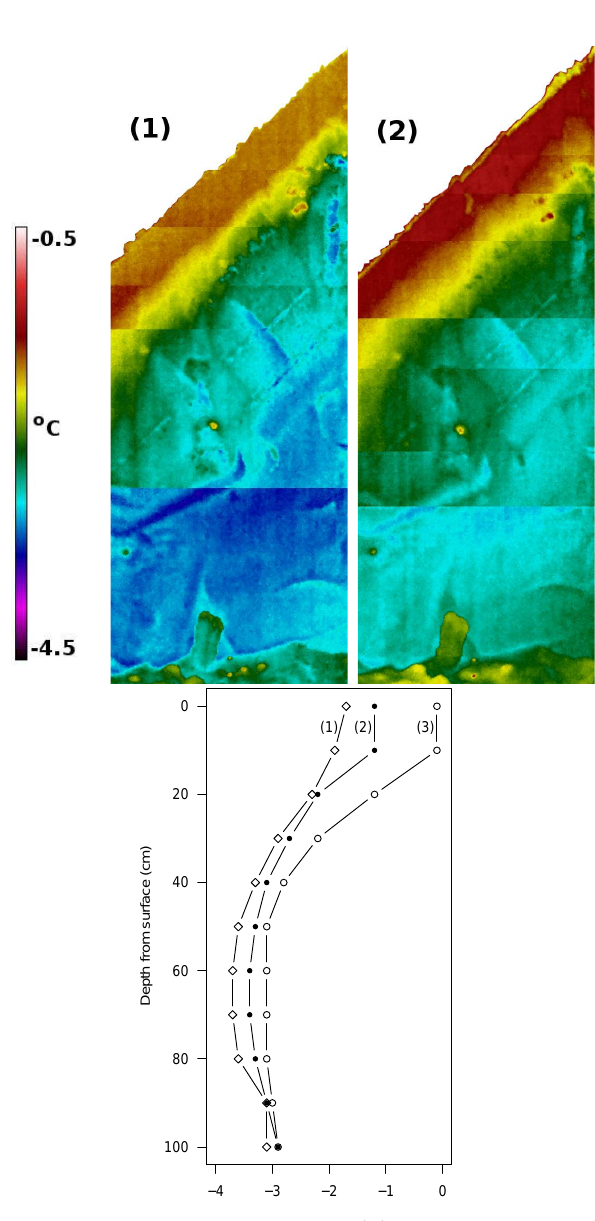
Fig. 5. Two thermography temperature profiles of the same pit, in order of time photographed (1 then 2), and one temperature profile performed in the same pit (3, in graph). For scale, the warmer layer near the surface (appearing as red) is ∼ 10 cm vertical width. The effect of operator heating and atmospheric heating is visualized between (1) and (2), and the effect of atmospheric and operator heating at depth combined with spatial variation is visualized by adding point profiles from 1 and 2 to the graph containing profile 3.